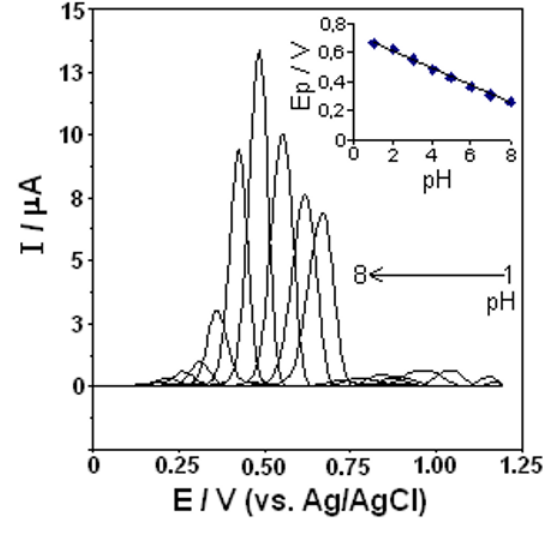
Figure 2. SW stripping voltammograms of 1 µg mL -1 rutin in BR buffer with different pH values (1.0, 2.0, 3.0, 4.0, 5.0, 6.0, 7.0 and 8.0). Inset: plot of E vs. pH. Accumulation time p 60 s at open-circuit condition; SW parameters: frequency, 50 Hz; scan increment, 8 mV; pulse amplitude, 20 mV.